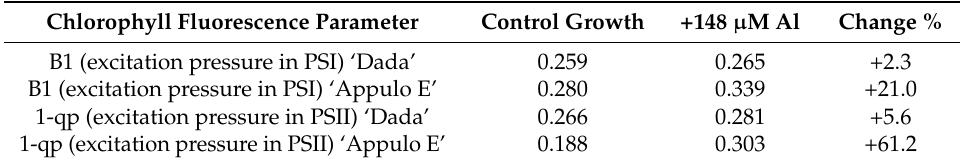
Table 2. PSI and PSII excitation pressure in the triticale ‘Dada’ and the durum wheat ‘Appulo E’, under normal growth conditions, under Al 3+ exposure, and the percentage change.